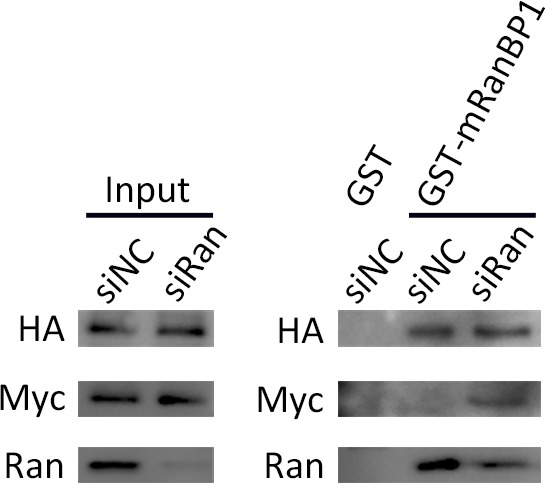
Pull down of 293 T cells expressed Ran fusion proteins using GST-mRanBP1 or GST, in the presence or absence of Ran knock down.Input lanes were used to ensure similar amount of Ran fusions present in each pull down sample. In the presence of Ran knock down, Ran fusions bound more to RanBP1, functionally rescues the reduction of bound RanWT.